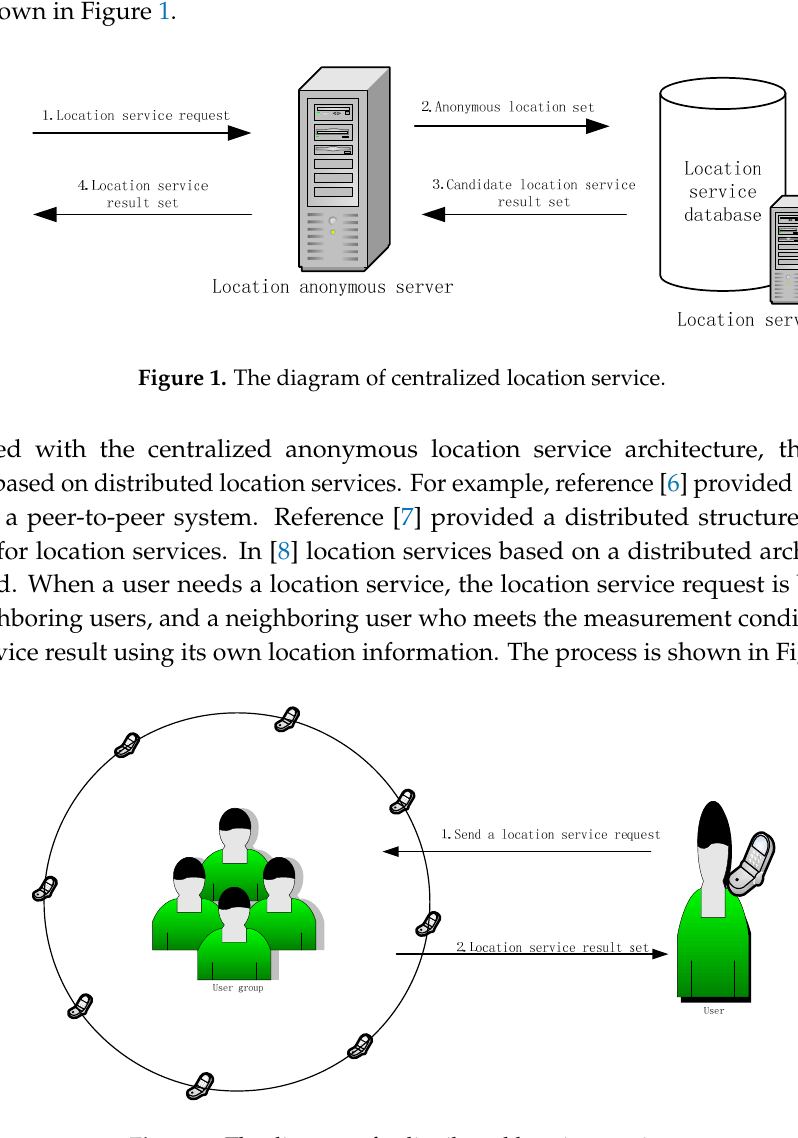
Figure 2. The diagram of a distributed location service.